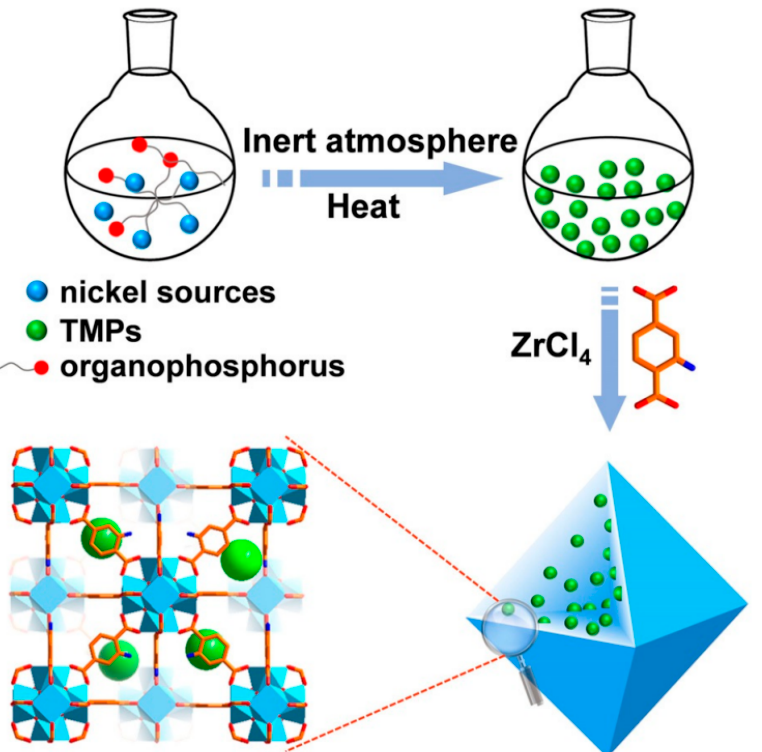
Figure 5. The schematic diagram of the synthesis steps for TMPs and TMPs@UiO-66-NH 2 . Repro- duced with permission from Ref. [69].